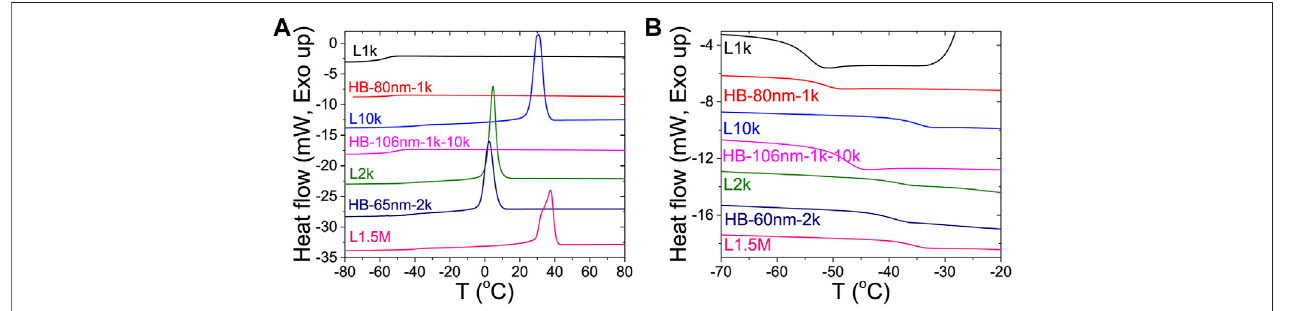
FIGURE 5 | DSC measurements of heat fl ow for different HB and linear PEO/LiTFSI electrolytes upon (A) cooling from 80 to − 90 ° C and (B) heating from − 90 to − 20 ° C. T c is capture in panel (A) and T g is capture in panel (B) and tabulated in Table 2 .